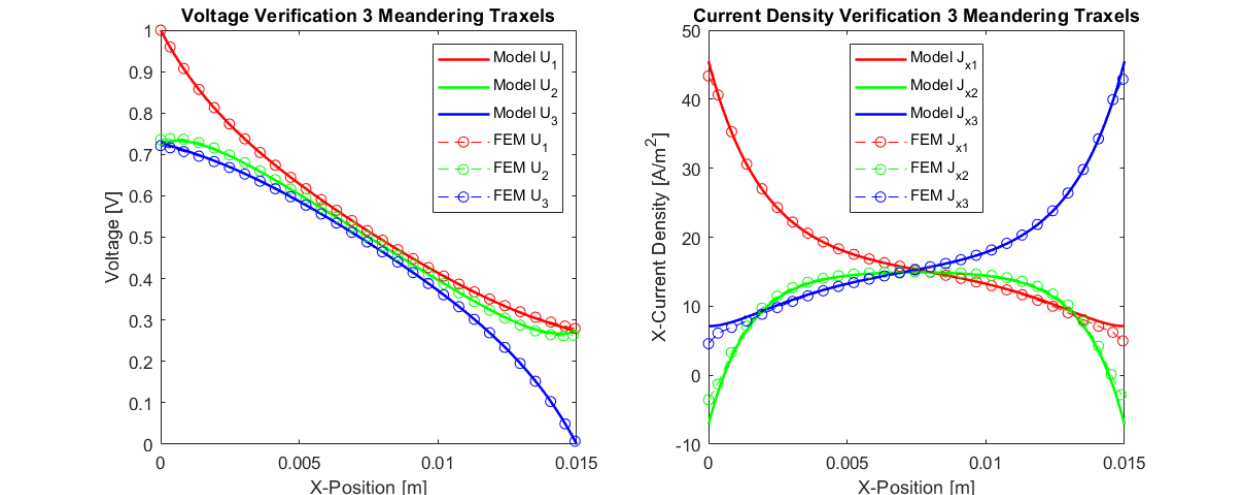
Figure 13. A comparison between the model and simulations of the dc voltage and current density in x -direction in the traxels of a sample with three traxels with meandering ends. The parameters listed in Table 2 are used and the number of traxels, N = 3, and inter-traxel resistance, σ = 2 × 10 − 2 Ω m 2 , are changed. The total resistance from the model is 137.4k Ω , which gives an error of 0.23% with the FEM